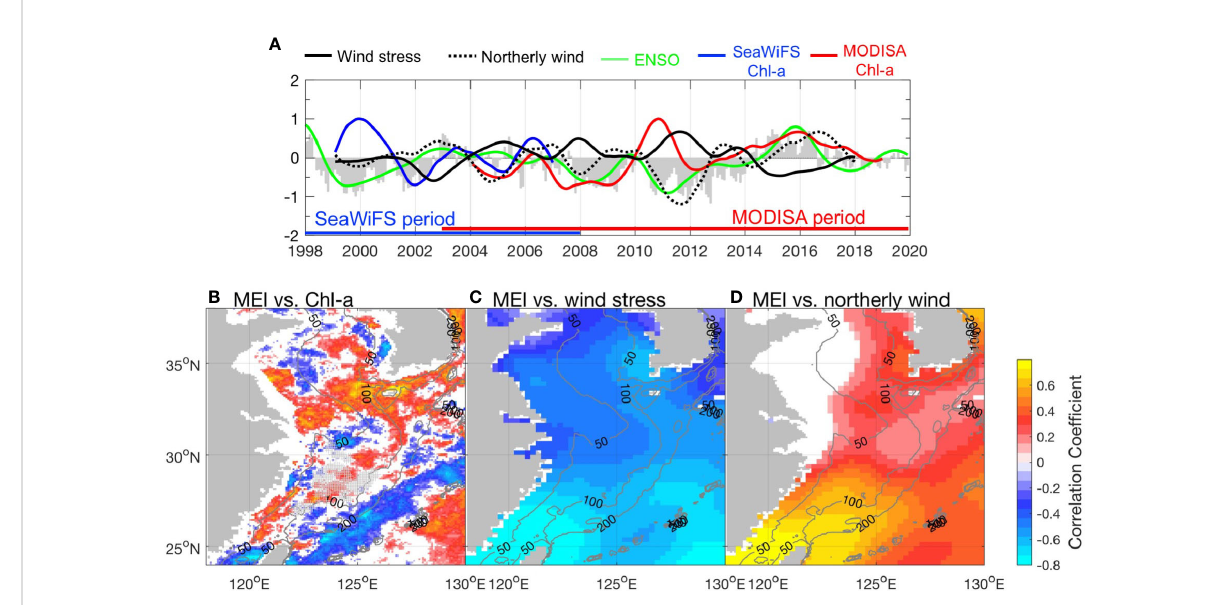
FIGURE 8 (A) The time series of the 12-month low-pass normalized EOF PC-1 for SeaWiFS (blue), MODISA (red) Chl -a , wind (solid black), northerly wind (dashed black), and MEI index (green). The gray bars denote the PDO index. (B) The correlation coef fi cient between MEI and Chl -a during 1998 – 2020. The area detected by EOF mode 1 with signi fi cant Chl- a anomalies is marked with a + sign. (C) The correlation coef fi cient between MEI and wind stress during 1998 – 2020. (D) The correlation coef fi cient between MEI and northerly wind during 1998 – 2020. All the correlation coef fi cients shown here surpassed the 95% signi fi cance level. The gray contour lines in each map denote the 50-, 100-, and 200-m